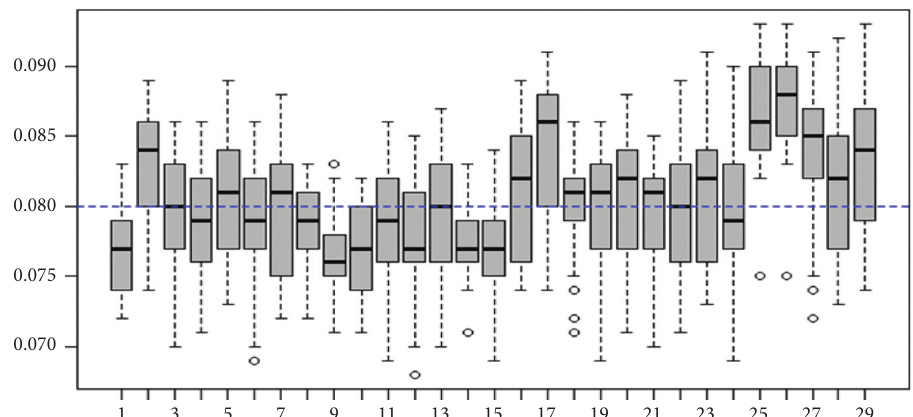
Figure 2: Box plot of the distribution of ozone concentration in the 29 air monitoring sites.